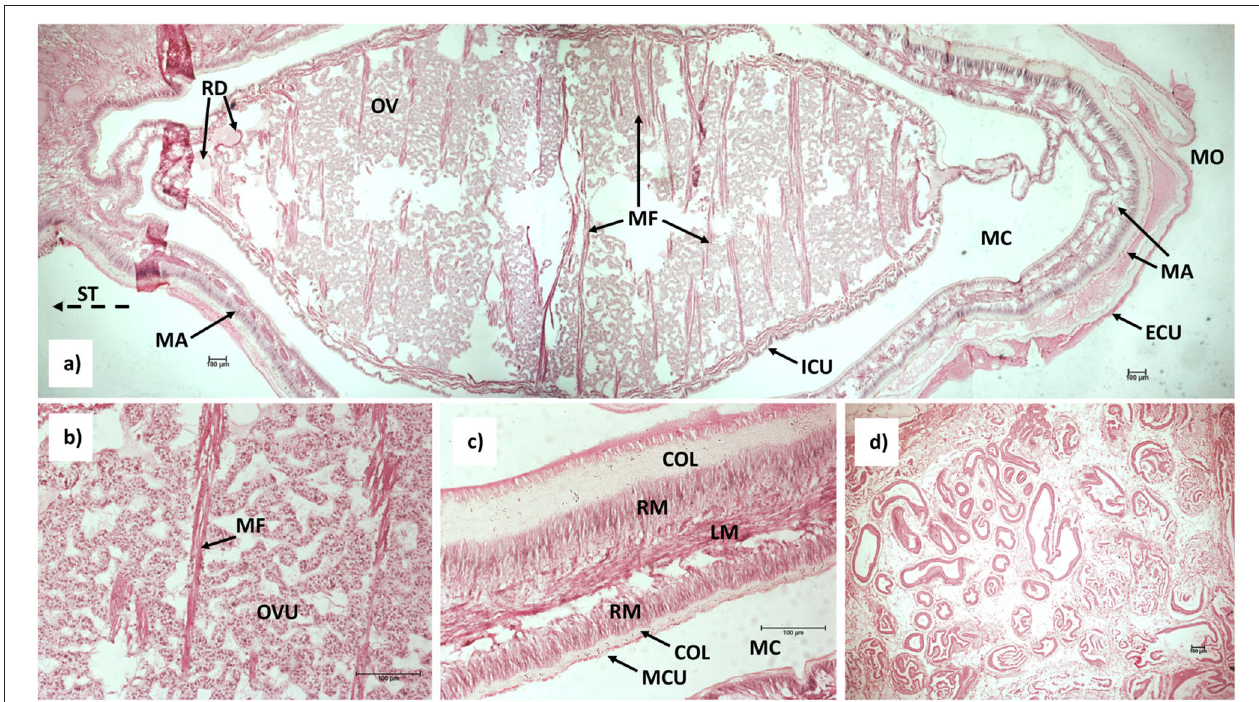
FIGURE 1 | Longitudinal section of the medial portion of (a) mature externa of Sacculina beauforti , magnification 4 × (note: three histological sections were combined into a single image, dashed-line arrow point toward stalk); (b) Developing ovules and muscle fibers within the internal cuticle, magnification 20 × ; (c) Detail of the mantle structure, magnification 20 × ; (d) Lateral section of the stalk depicting numerous tubules, magnification 4 × . Collagen fibers (COL), external cuticle (ECU), internal cuticle (ICU), longitudinal muscle layer (LM), mantle (MA), mantle cavity (MC), mantle cavity cuticle (MCU), muscle fibers (MF), mantle opening (MO), ovary (OV), ovules (OVU), receptacle duct (RD), radial muscle layer (RM), stalk